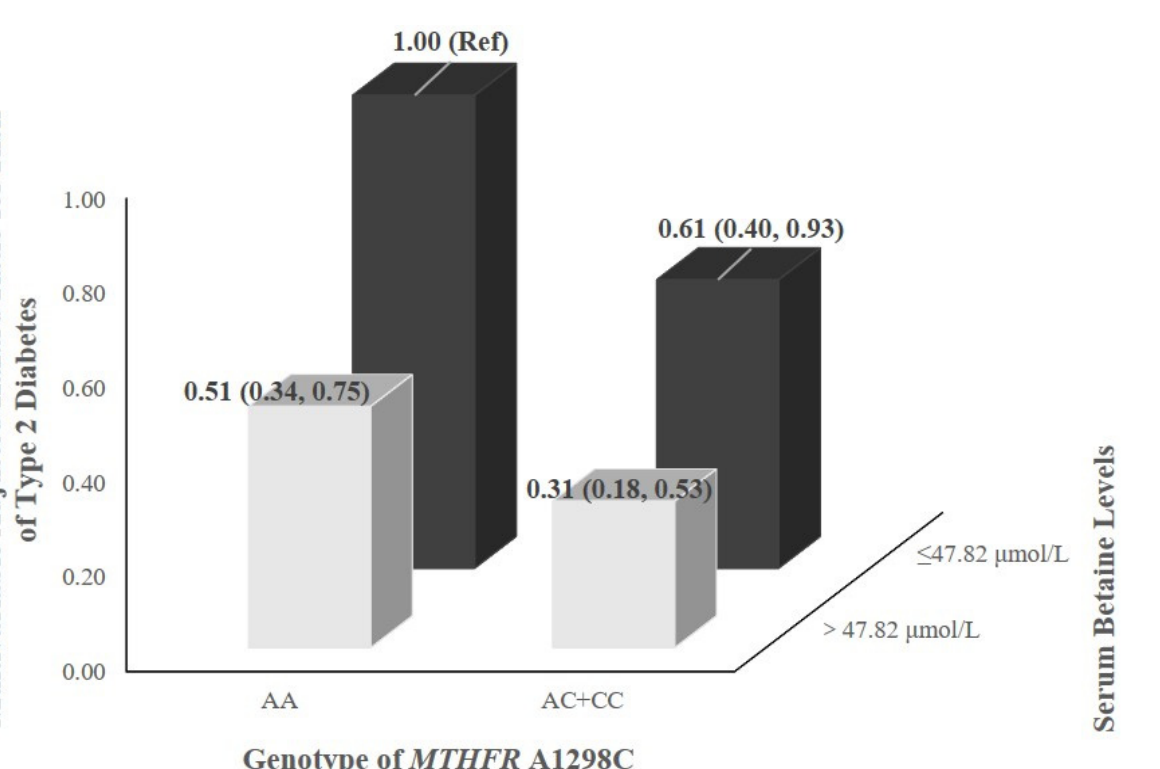
Figure 2. Interaction of serum betaine and genotypes of MTHFR G1793A or A1298C on the association with risk of type 2 diabetes in the Guangzhou Nutrition and Health Study.